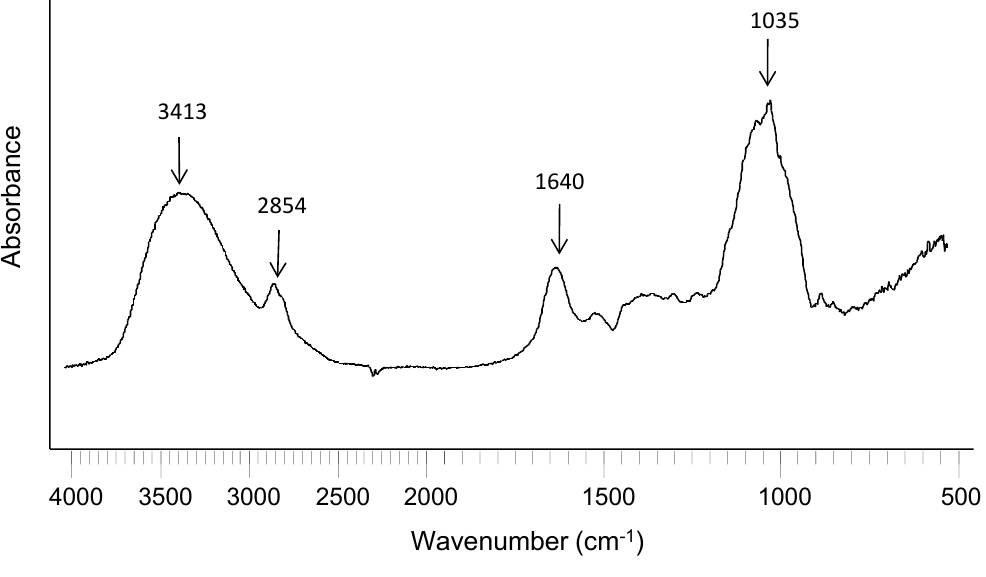
Figure 1. FT-IR spectrum of non-cross-linked WEAX.